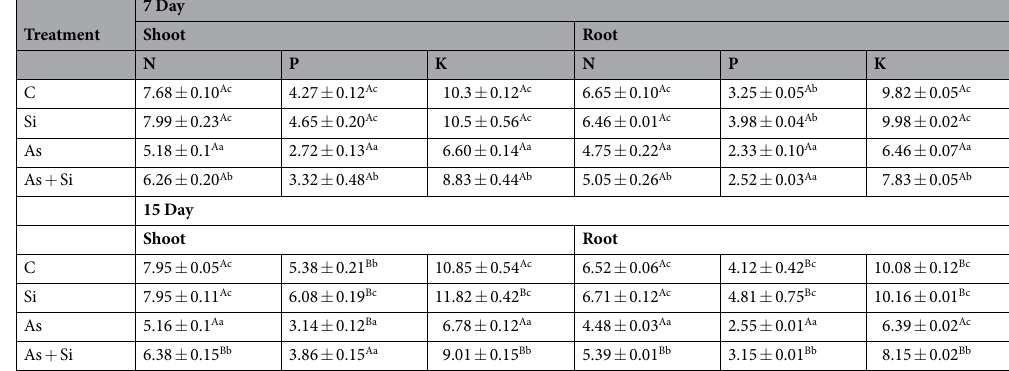
Table 3. Nitrogen (N), Phosphorus (P) and Potassium (K) content in shoot and root of Oryza sativa var. IR64 under As (III) and Si supplementation at 7 and 15d exposure period. Values are mean ( ± S.D) of three independent replicates (n = 3). Different letters represent significant differences between each treatment at p < 0.05. The small latter (i.e. a, b, c and d) indicates the significant difference between treatment in same tissue type while capital latter (i.e. A and B) indicates the significant difference between duration among the same treatment in same tissue